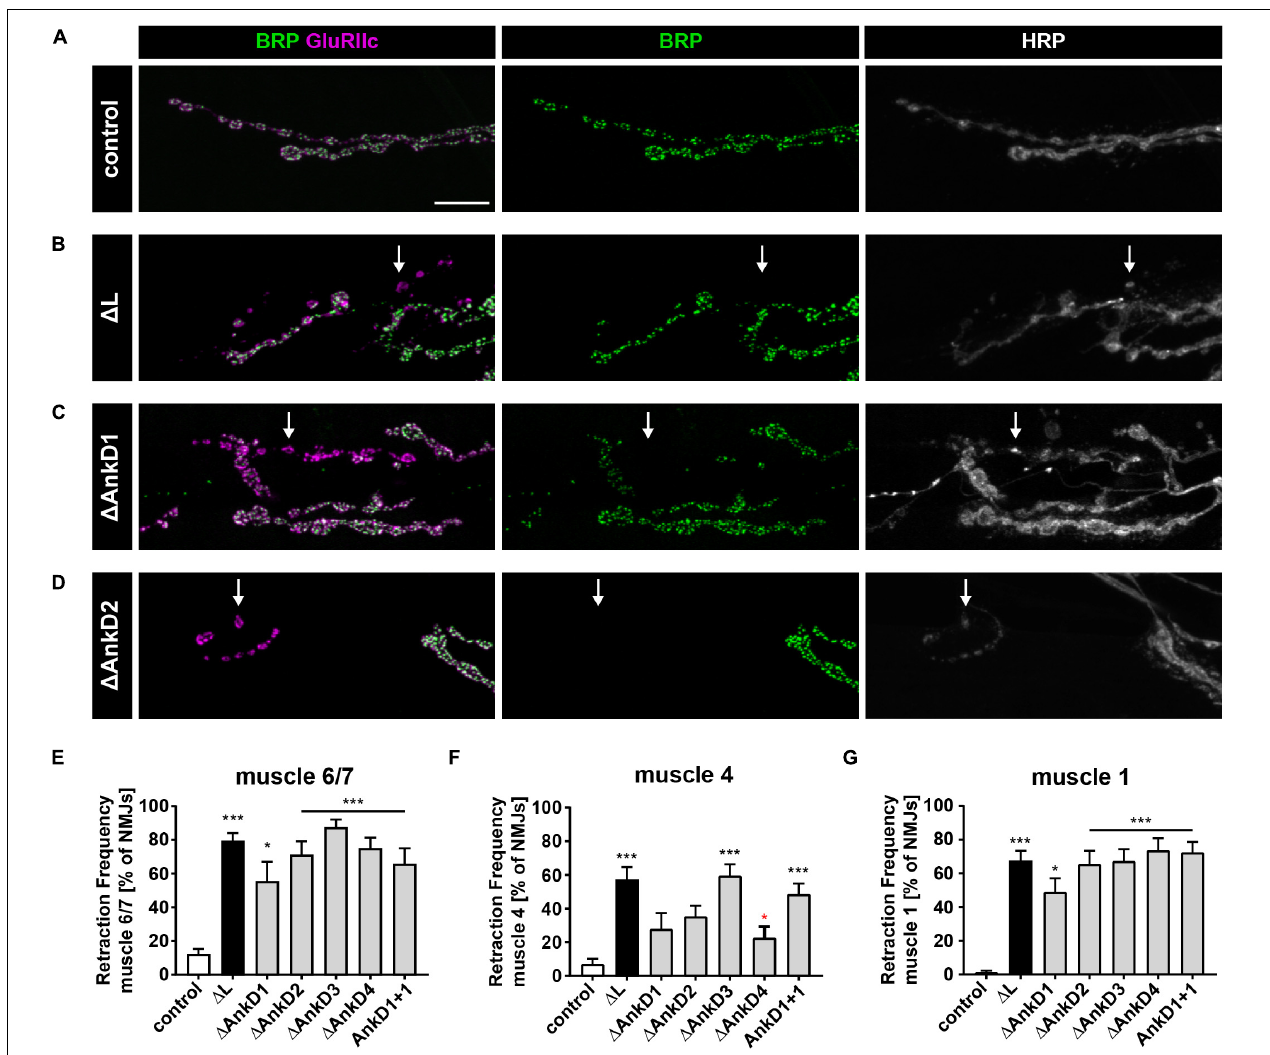
FIGURE 5 | ARD is essential for Ank2-L mediated synaptic stability. (A–D) Analysis of synaptic stability using the presynaptic active zone marker Brp (green), the postsynaptic marker GluRIIc (magenta) and the presynaptic membrane marker HRP (white). (A) In control animals ( P[ank2_wt] /+; ank2 (cid:49) L /ank2 null ) presence of the wild type P[acman] ank2 constructs completely restores the synaptic stability defects associated with the ank2 (cid:49) L mutation. (B) In the absence of Ank2-L synaptic retractions are evident as postsynaptic GluRIIc clusters no longer opposed by the presynaptic maker Brp (arrow). The presynaptic membrane is fragmented in these areas. (C,D) Rescue constructs containing deletions of the first (C) and second (D) AnkD fail to completely restore synaptic stability defects in the ank2 (cid:49) L mutant background (arrows). (E–G) Quantification of the frequency of synaptic retractions on muscles 6/7 (E) , muscle 4 (F) and muscle 1 (G) in control, ank2 (cid:49) L and (cid:49) AnkD mutants ( n = 72–111 muscle 6/7 NMJs, 12–19 animals; n = 66–101 muscle 4 NMJs, 11–19 animals; n = 71–104 muscle 1 NMJs; 12–19 animals). Scale bars in (A) apply to (A–D) and represent 10 µ m. Error bars indicate SEM; ∗ p < 0.05, ∗∗∗ p < 0.001 (ANOVA); black asterisks represent comparisons to controls; red asterisks represent comparisons to ank2 (cid:49) L